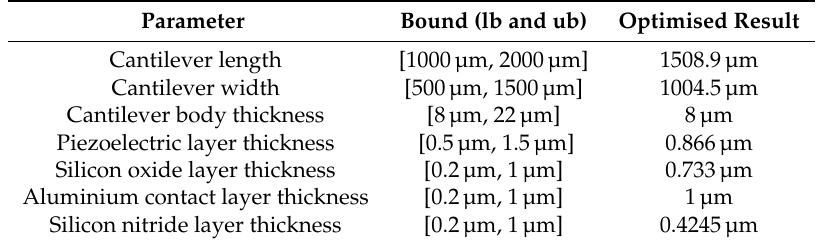
Table 3. Optimization result for the cantilever beam geometric parameters using BOBYQA algorithm.